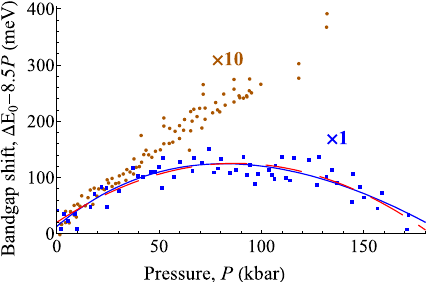
Figure 2. GaAs band-gap. Data for E g ( P ) in GaAs from Goñi et al . 28 ( ■ ) and from Perlin et al . 29 ( • ) are shown after subtraction of the straight line E 0 + 8.5 P to make the curvature more visible. The Perlin data is expanded × 10 on both axes for clarity. Two least-squares fits to the Goñi data are shown, polynomial (dashed red line) and Murnaghan (solid blue line). (Figure prepared using Mathematica 12.0, www. wolfr am. com/ mathe